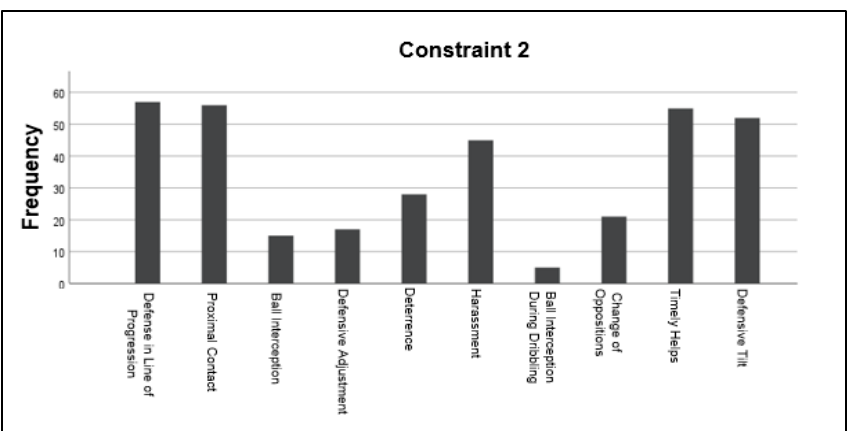
Figure 3. The frequency in which handball’s motor behaviors were activated during the exercise where constraint 2 (One attacker with one ball) was applied.